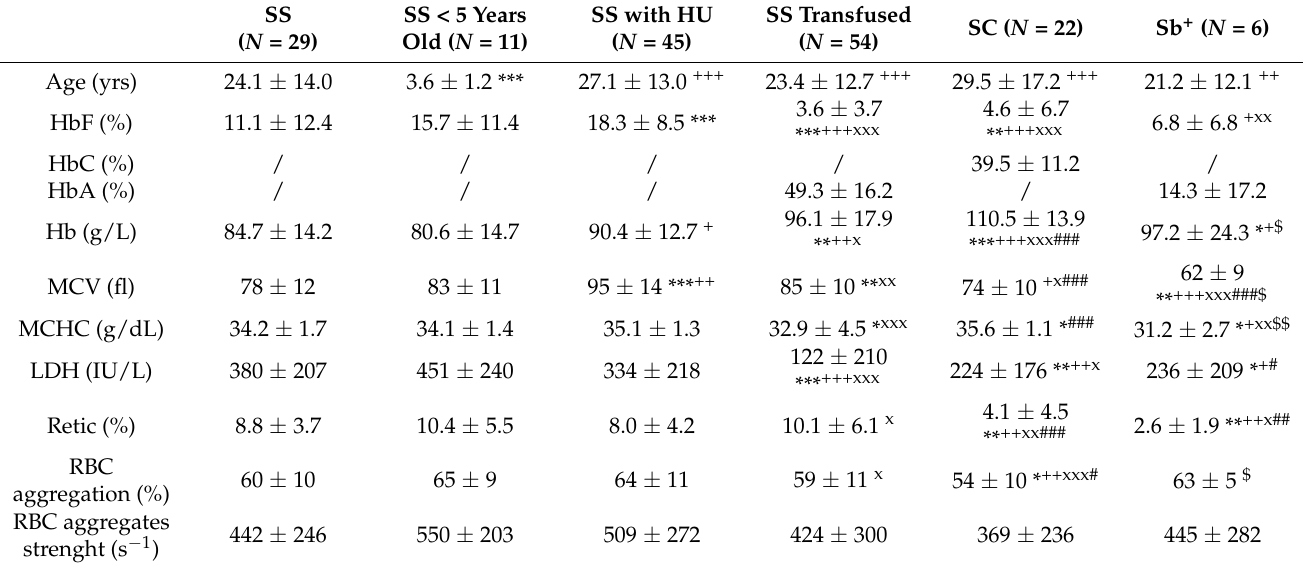
Table 1. Baseline hematological parameters and RBC aggregation in the 6